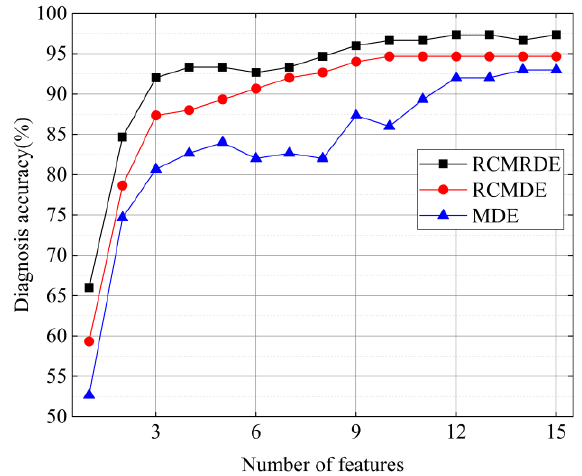
Figure 13. The diagnosis accuracy of three methods.